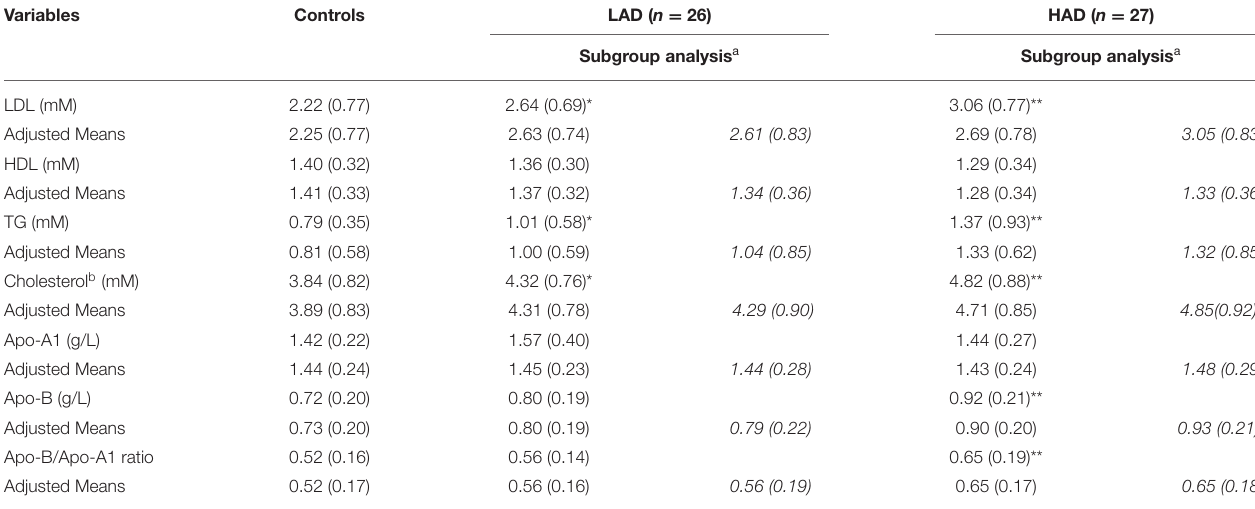
TABLE 2 | Different biomarkers for lipid status in childhood cancer survivors with low (LAD) or high (HAD) cumulative dose of anthracyclines. Variables